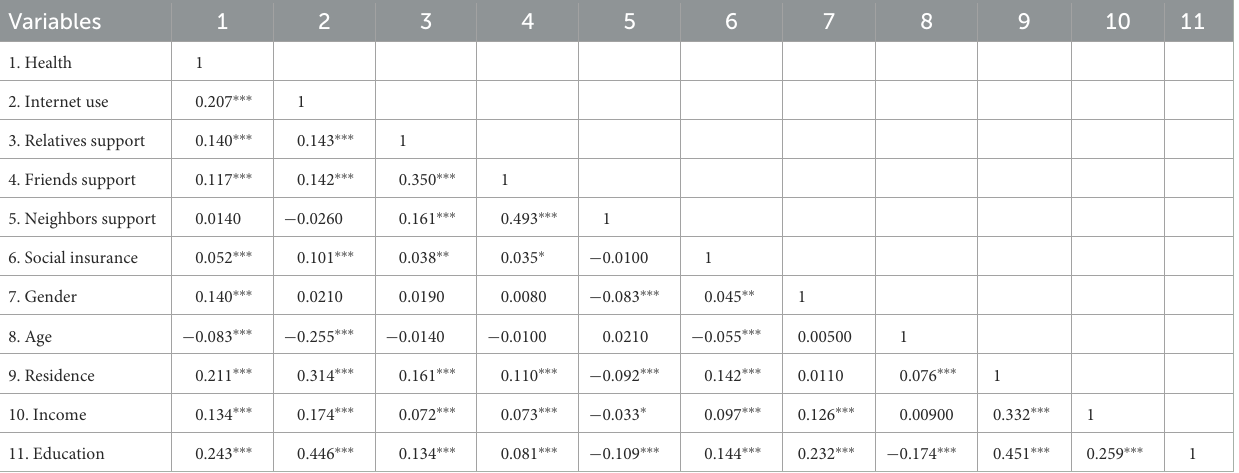
TABLE 3 Pearson’s correlations among relevant study variables.